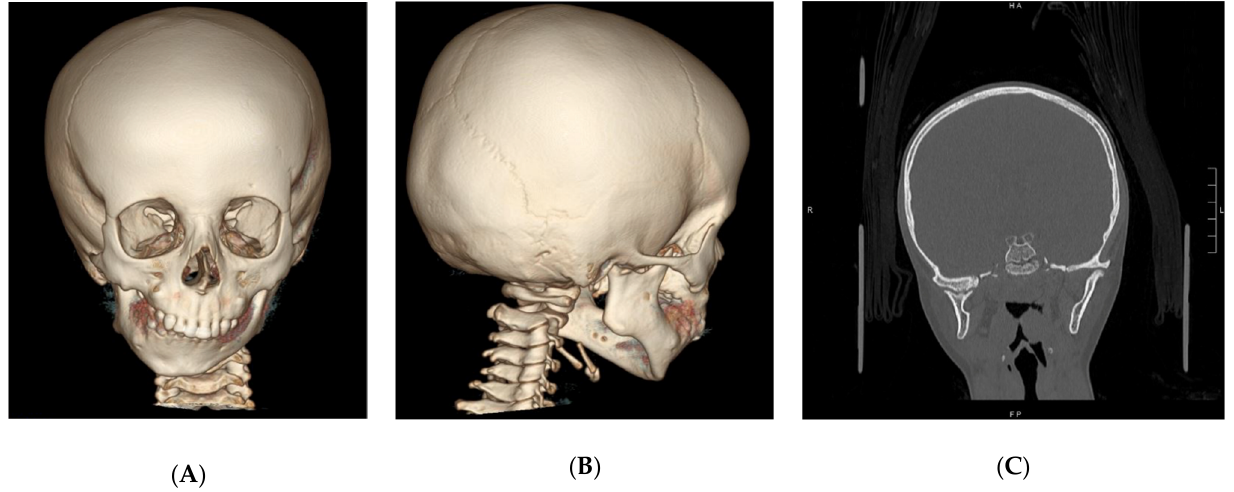
Figure 2. First radiographic evaluation: ( A , B ) Preoperative 3D CT scan, showing the shortness of the condylar neck and the resulting right deviation; ( C ) CT scan coronal section showing the ankylotic bloc.